Question: Express in one sentence what the figure is showing.
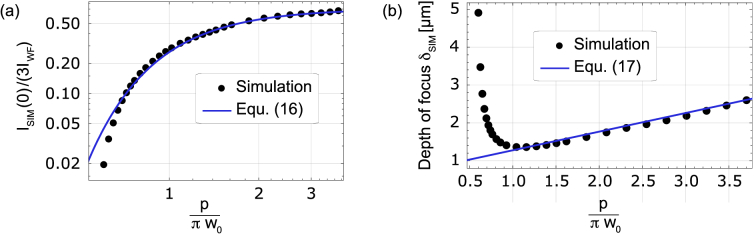
Answer: Structured illumination sectioning in coherent reflection microscopy: numerical and analytical analysis. (a), calculated normalised intensity as a function of p normalized to π w 0 (black dots), and theoretical predictions from Equ. ( 16 ) (blue line) showing excellent agreement. Both are normalised to the full field case with equivalent illumination, corresponding to I 1 + I 2 + I 3 . (c), simulated depth of focus as a function of p normalized to π w 0 (black dots), and theoretical predictions from Equ. ( 17 ) (blue line) in agreement for p π w 0 ≥ 1 . Analytical predictions for smaller values diverge from the exact calculation that reaches a minimum for p = π w 0 .